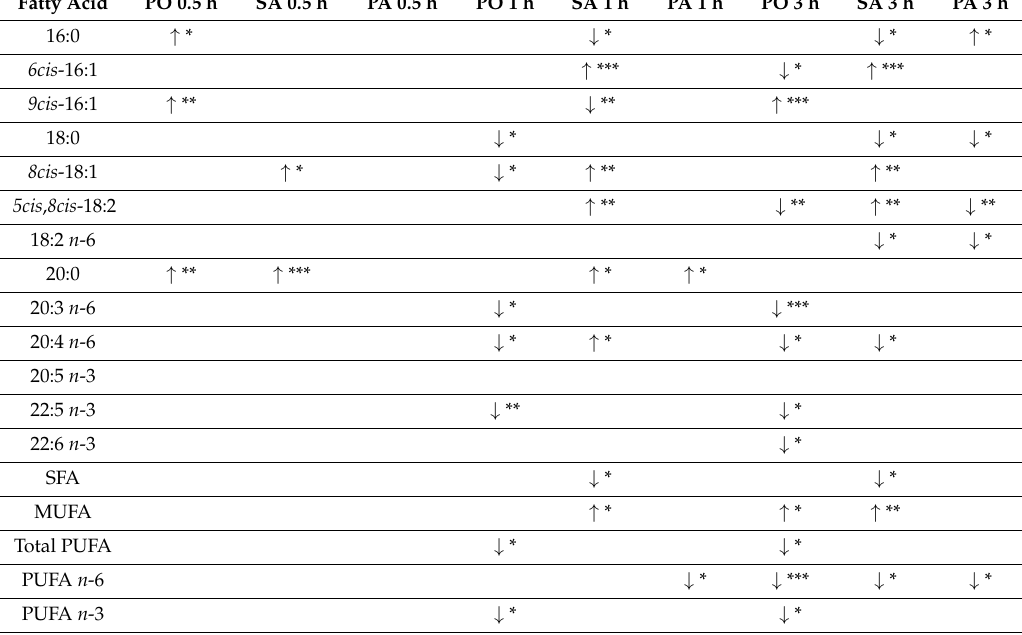
Table 2. Statistically significant trends of fatty acids in membrane phospholipids (increase ↑ or decrease ↓ ) after treatment with 150 µ M PO (palmitoleic acid), SA (sapienic acid) and PA (palmitic acid) in the interval time of 0.5–3 h. The analysis of fatty acid as methyl esters (FAME) was carried out as reported in Section 2. Values are presented in Tables S1, S3 and S5. Significance: * p ≤ 0.049, ** p ≤ 0.009; *** p ≤